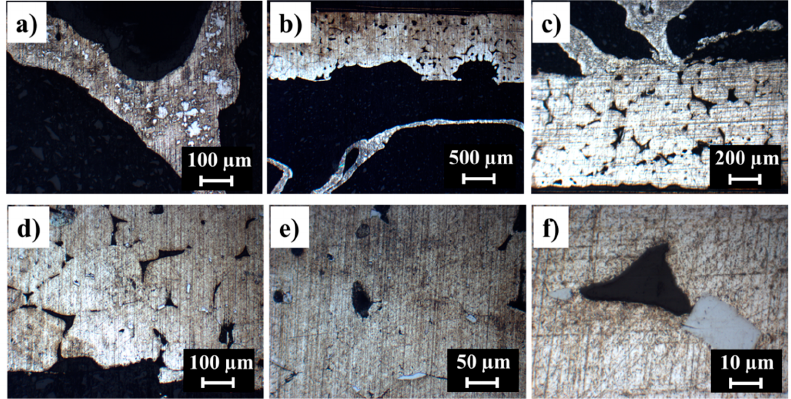
Figure 4. Macrographs, showing the Al-alloy sheet/Al-alloy foam joint produced using Al-Cu-Mg amorphous alloy, ( a ) Al-alloy foam, ( b , c ) Al-alloy sheet/Al-alloy foam joint interface, and ( d – f ) Al-alloy